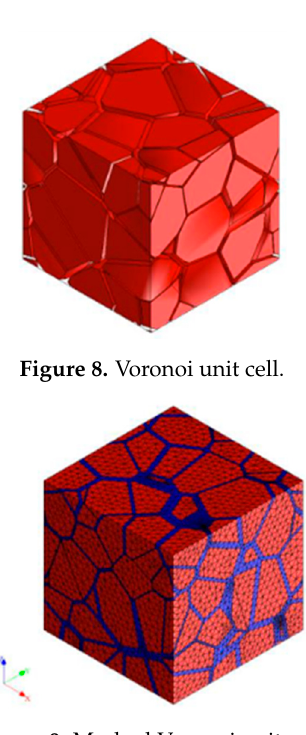
Figure 9. Meshed Voronoi unit cell.